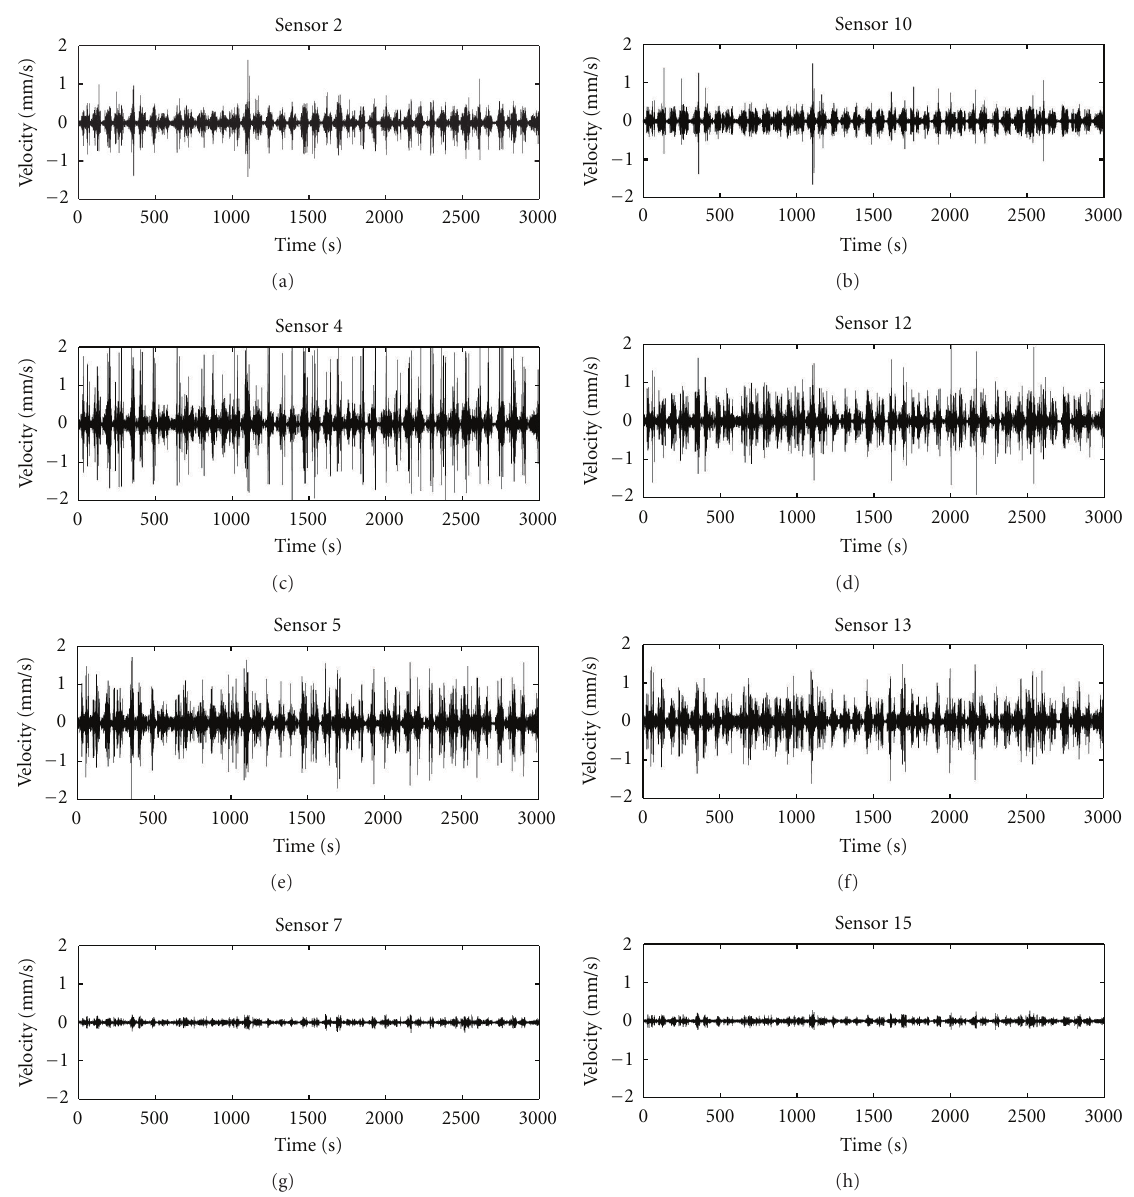
Figure 2: Recorded ambient vibrations (vertical component) at 8 sensors (see also Figure 1(c)) along the two sides of the bridge deck in the time period from 10:00 to 10:50 UTC. Note the large number of transient signals, which are due to the tra ffi c crossing the bridge. Also note the variations in amplitude of the signals along the bridge